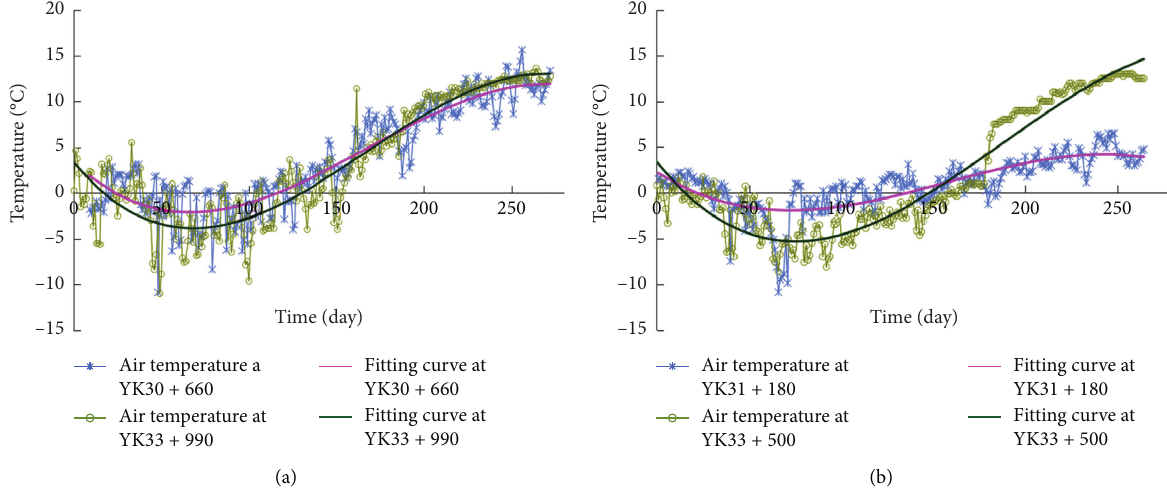
Figure 12: The air temperature curves in the tunnel with different distance vs. time. (a) Air temperature in the tunnel portal. (b) Air temperature away from the tunnel portal of